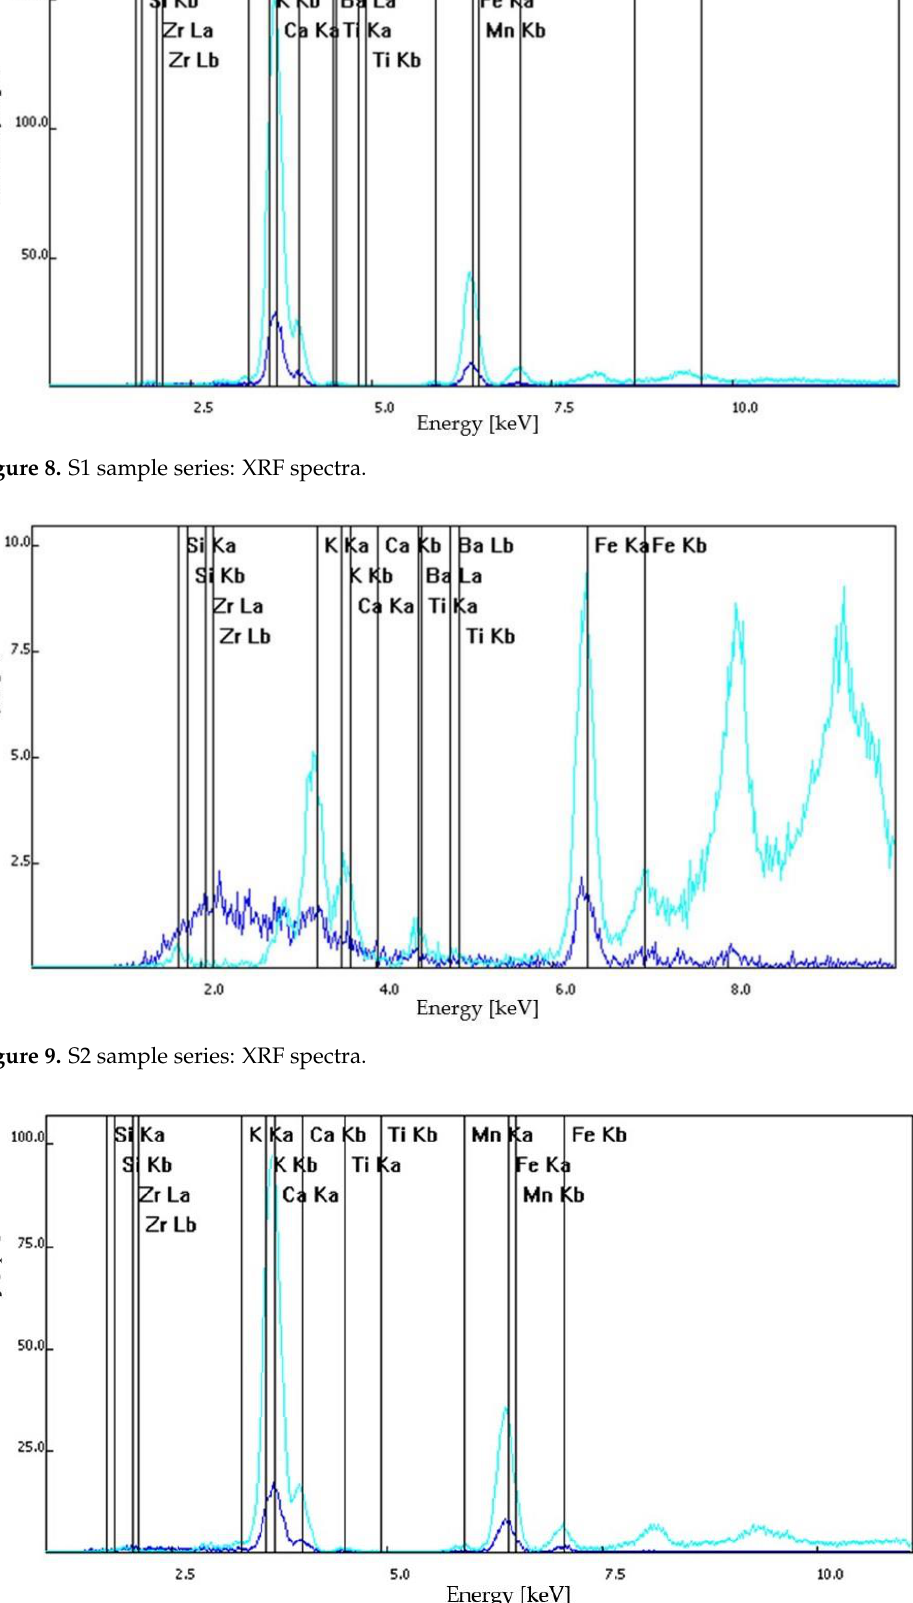
Figure 11. S4 sample series: XRF spectra. The primary and secondary minerals found in the composition of the samples were highlighted by a microscopic examination (Figure 12). The dimensions of the primary components of the S1 sample, dislodged from the original wall of Frumoasa monastery, are listed in Table 3.